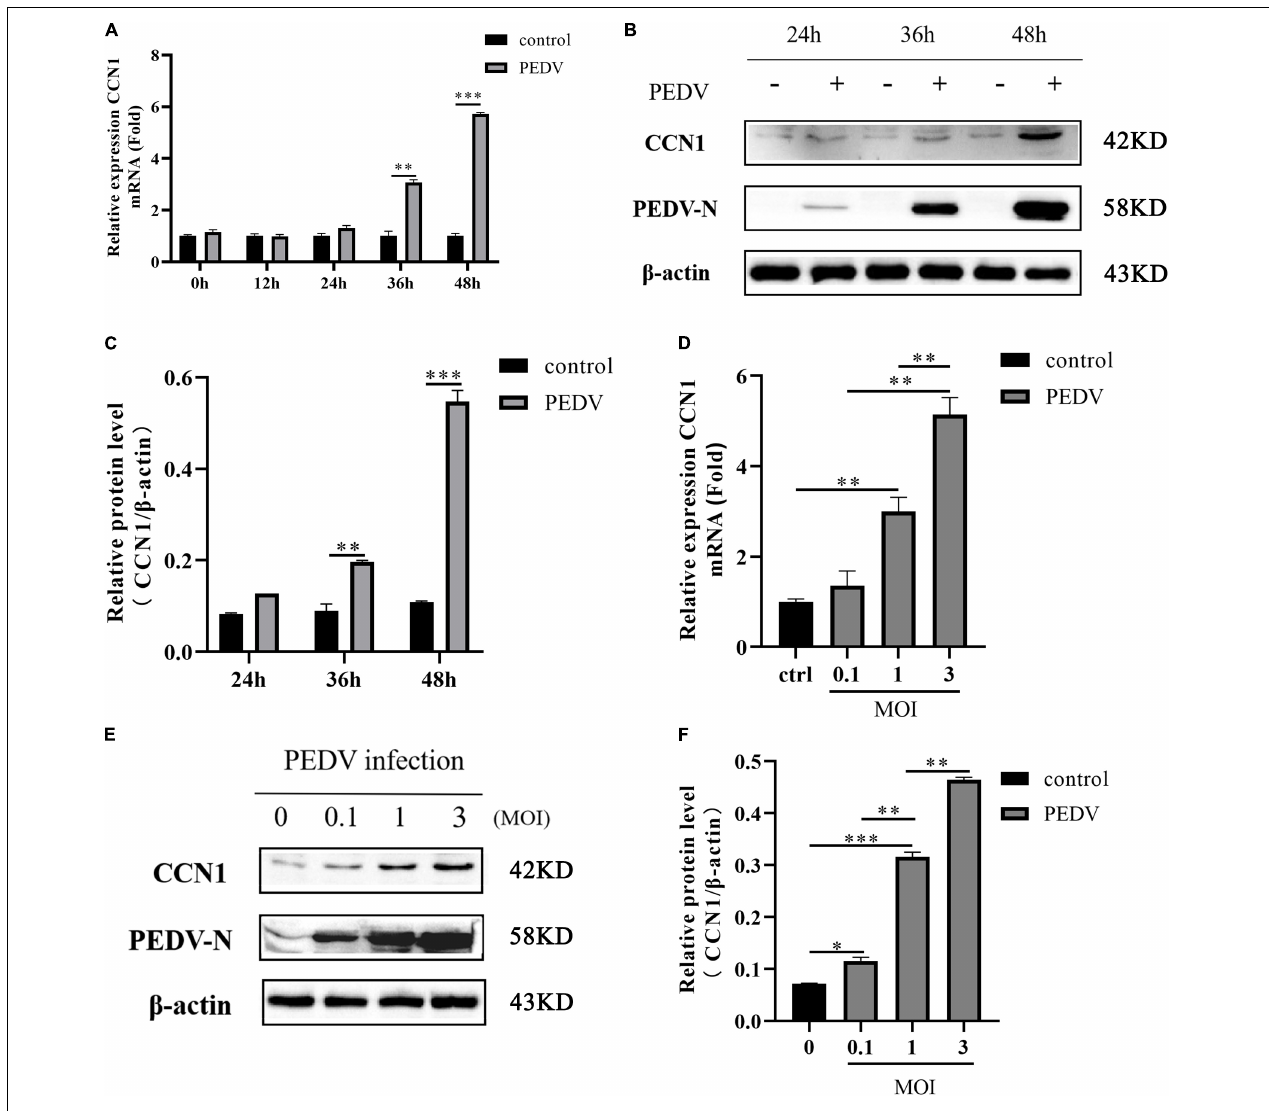
FIGURE 1 | Porcine epidemic diarrhea virus infection induces CCN1 expression in Marc-145 cells. (A,B) Marc-145 cells were incubated with PEDV at MOI of 1, and then, the cell was harvested at indicated time point post-infection. Quantitative real-time PCR was used to detect CCN1 expression (A) and Western blotting was used to analyze CCN1 protein levels (B) . (C) Densitometric analysis of CCN1 relative to β -actin using ImageJ. (D,E) Marc-145 was infected with PEDV at MOIs of 0.1, 1, and 3 for 48 h, and the cells were collected to analyze CCN1 mRNA levels using real-time PCR (D) and CCN1 protein levels by Western blotting (E) . (F) Densitometric analysis of CCN1 relative to β -actin using ImageJ. The data were performed from three independent experiments. The differences were evaluated using Student’s t -test, and significance differences were denoted by ∗ p < 0.05, ∗∗ p < 0.01, and ∗∗∗ p < 0.001. cell lines. We performed similar experiments using Vero